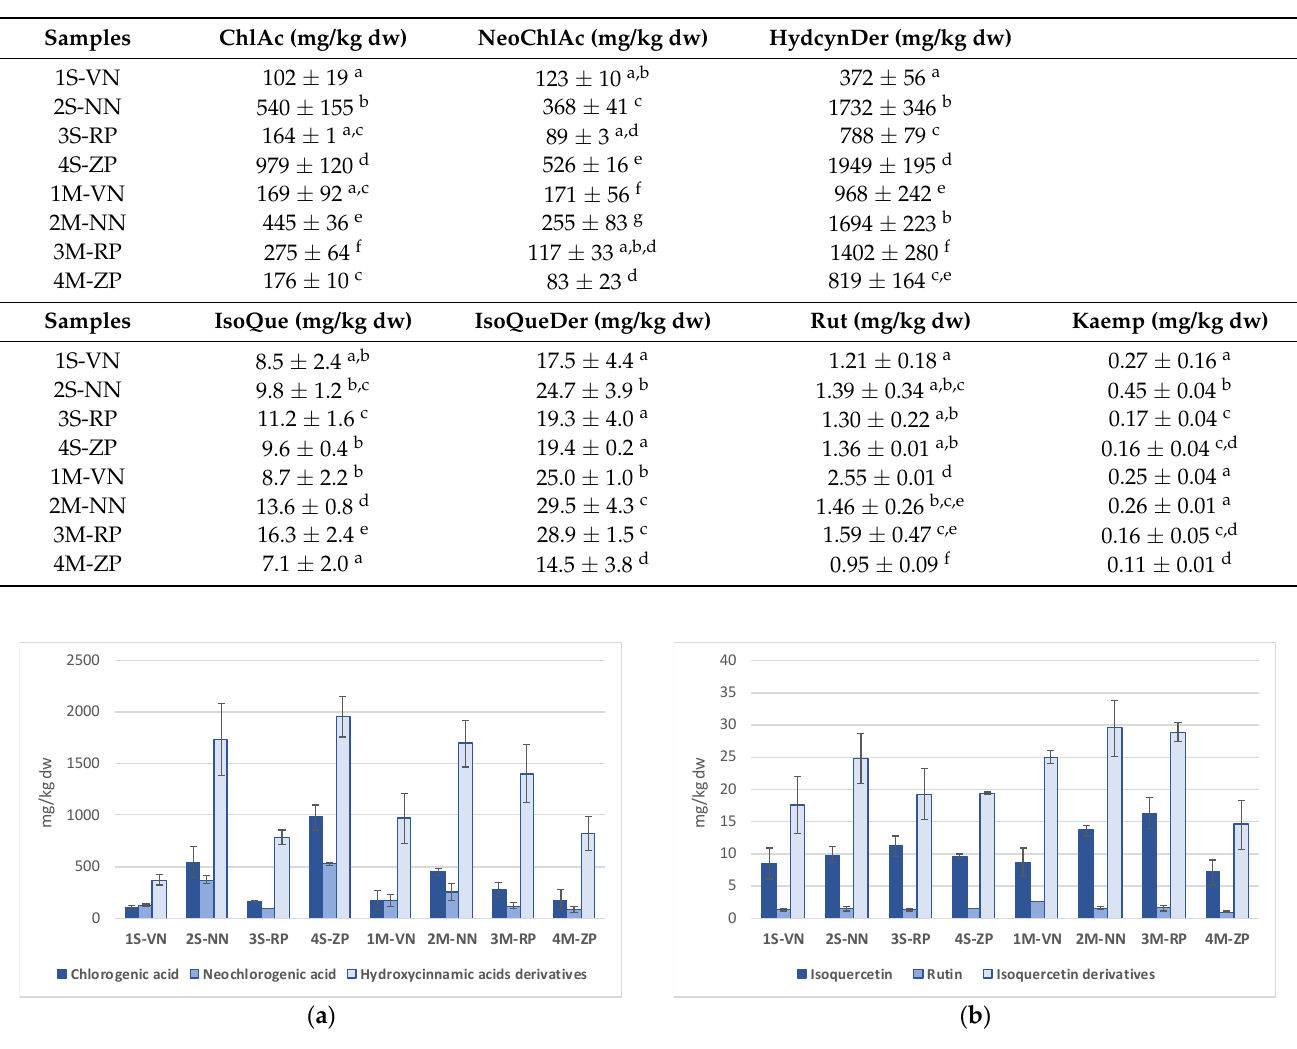
Table 4. Contents of chlorogenic acid (ChlAc), neochlorogenic acid (NeoChlAc), hydroxycinnamic acids derivatives (Hyd- cynDer), isoquercetin (IsoQue), isoquercetin derivatives (IsoQueDer), rutin (Rut) and kaempferol (Kaemp) in hydroalcoholic extracts (MeOH/H 2 O; 80:20%, v / v ) of peaches and nectarines mesocarp samples. The values are expressed as mean ± SD ( n = 27; mg/kg dw). Values marked with the same letter within the same column (for each analyte) are not statistically different (Tukey’s test, p > 0.05).